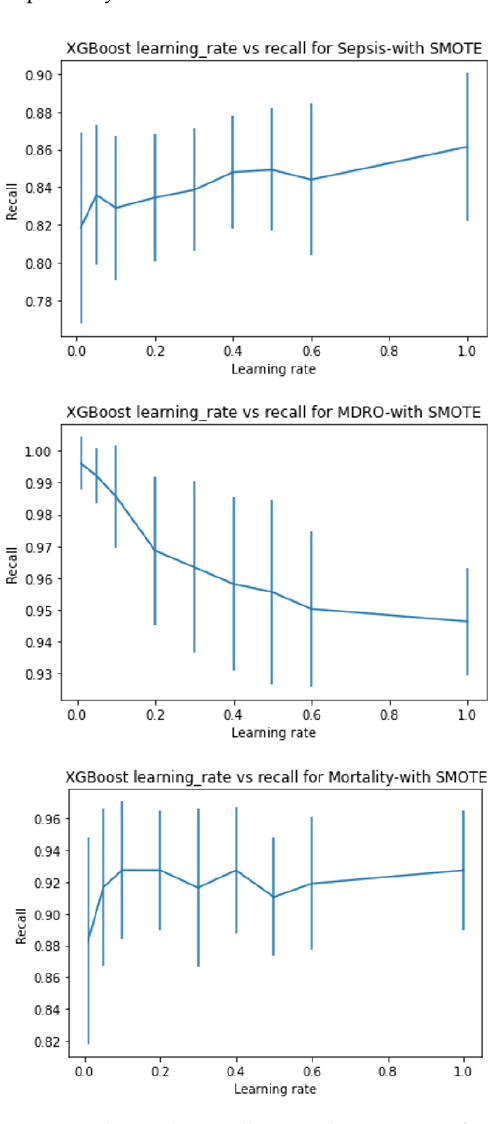
Figure 4. Shows the recall versus learning rate for all three outcomes with data augmentation on the training set, plotted using XGboost as the base model. With data augmentation, the event prediction capability of models are 82–85%, 95–99%, and 88–93% for sepsis, MDRO, and mortality,